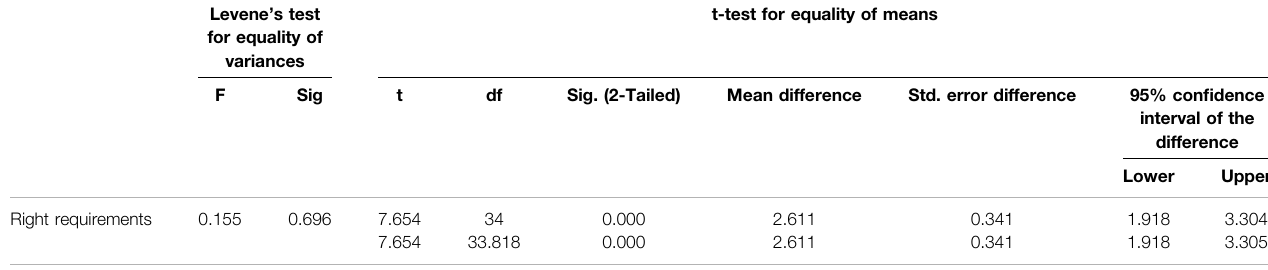
TABLE 11 | Results of the independent samples test. Levene ’ s test for equality of